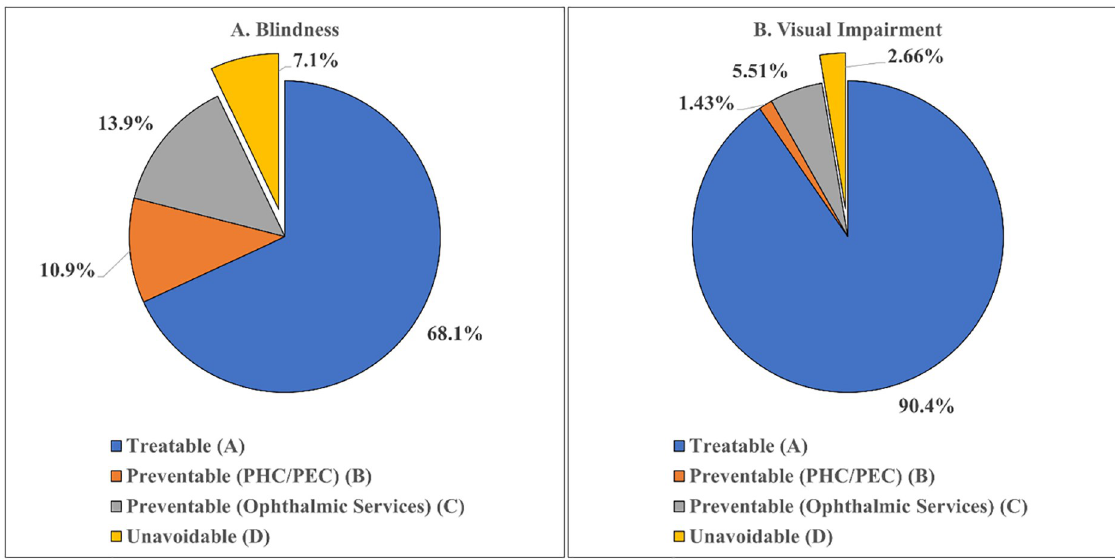
Fig 3. Categories of blindness and visual impairment by intervention (A and B